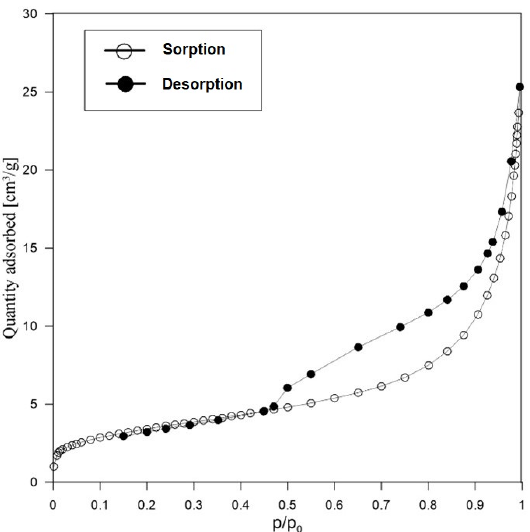
Table 3. Results of the porous texture analysis of samples [45,48]. Figure 7. Isotherm of N 2 sorption/desorption on RM sample after calcination.